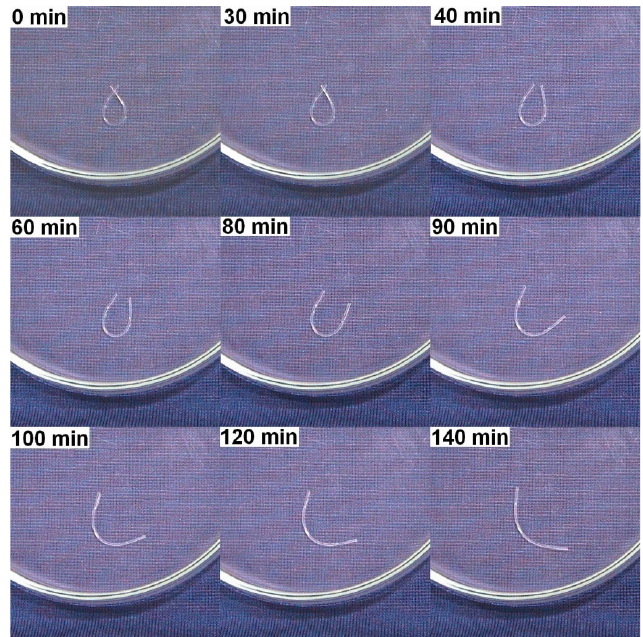
Figure 7. Water-responsive SME (shape recovery of PU polyurethane in room temperature water). (Reproduced with permission from [101]. Copyright 2005 American Institute of